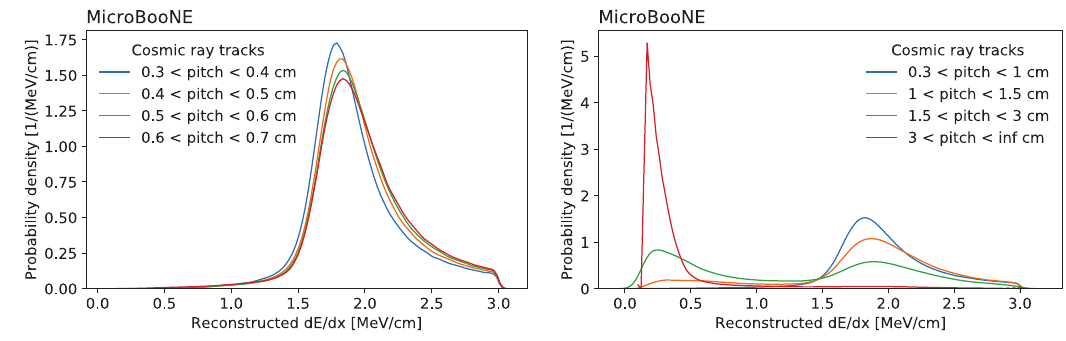
Figure 3. Normalized distributions of d E/ d x for different local pitch in the low-local pitch regime (left) and over the entire local pitch spectrum (right), as measured on the collection plane in a sample of cosmic muons tracks in the MicroBooNE